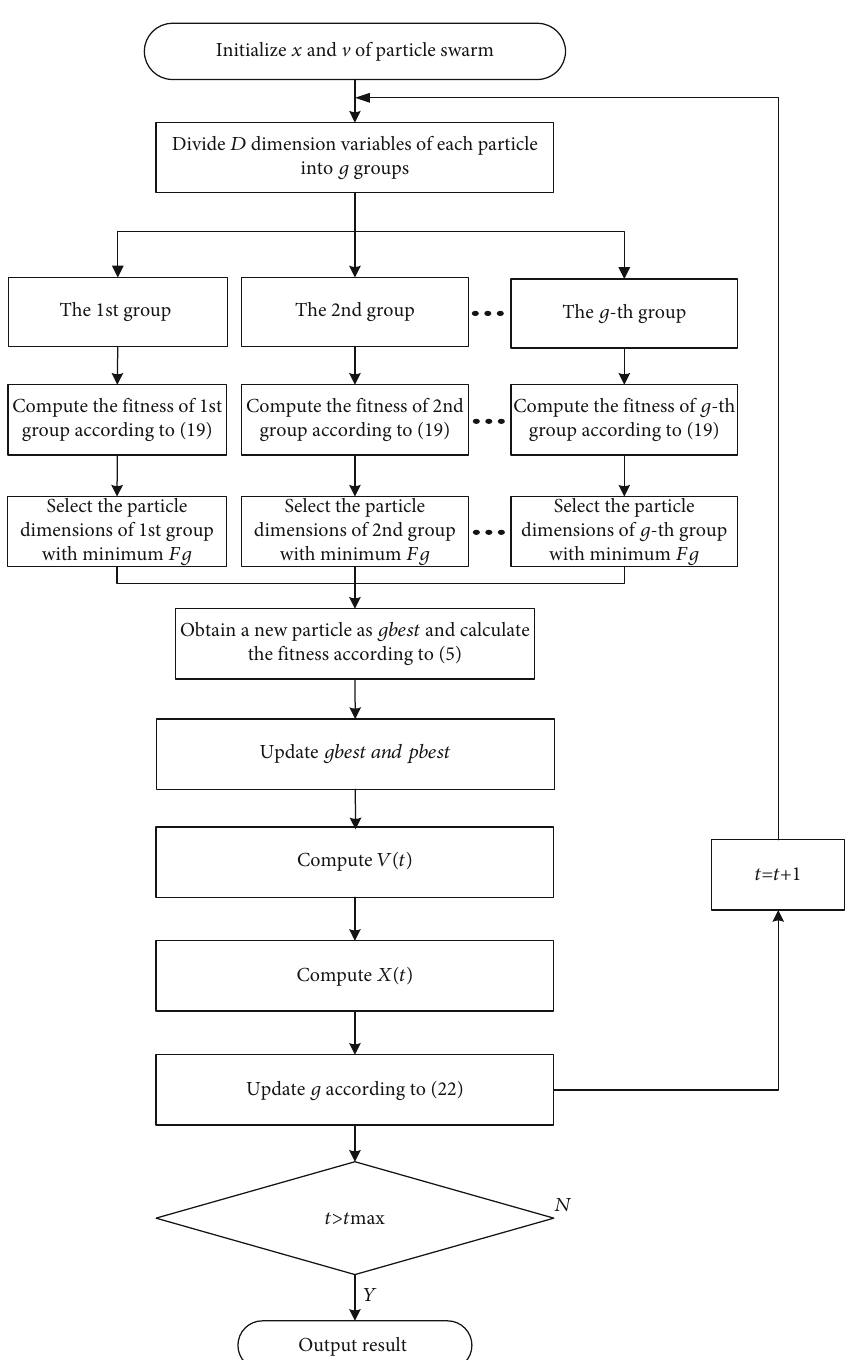
Figure 3: The fl ow chart of PSO with divide-and-conquer (DC)